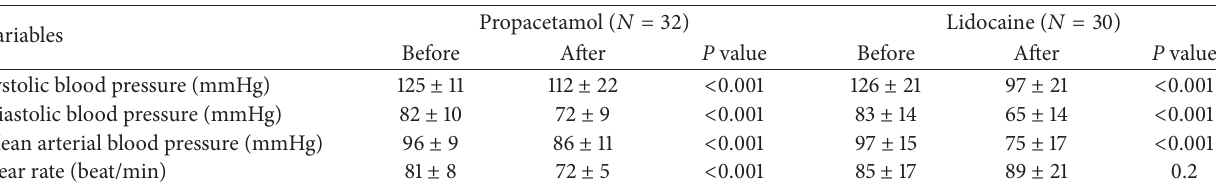
Table 2: Hemodynamic variables including systolic, diastolic, and mean arterial blood pressures (SBP, DBP, MAP) and heart rate (HR) before and after drug in each group.